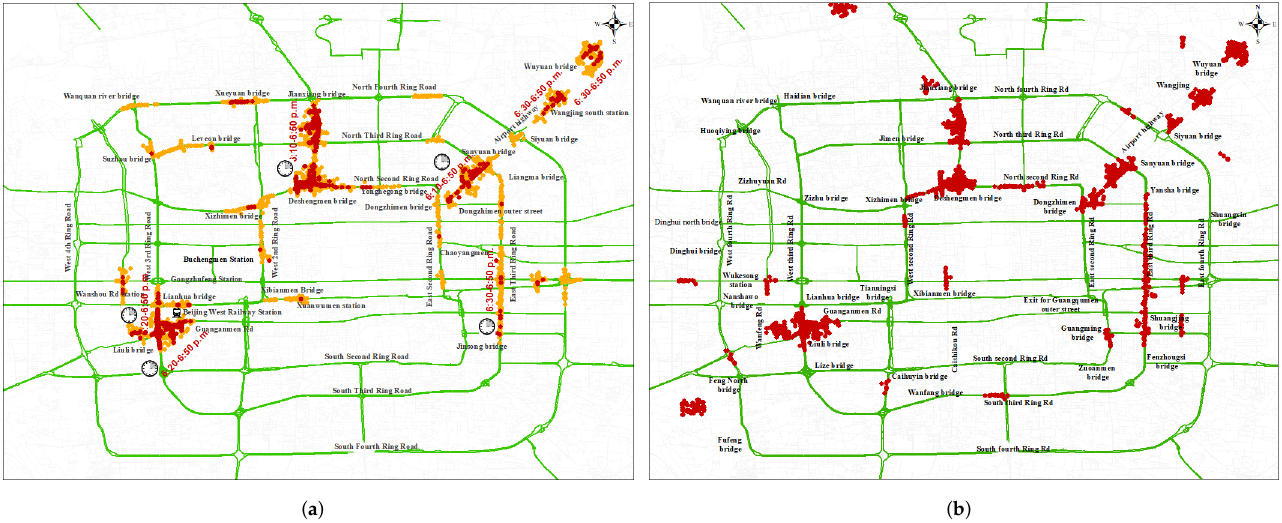
Figure 9. The discovered congested pattern between 5:00 and 7:00 p.m. on weekends. ( a ) The LMCPs generated by our algorithm; ( b ) The swarm pattern generated by CLUR